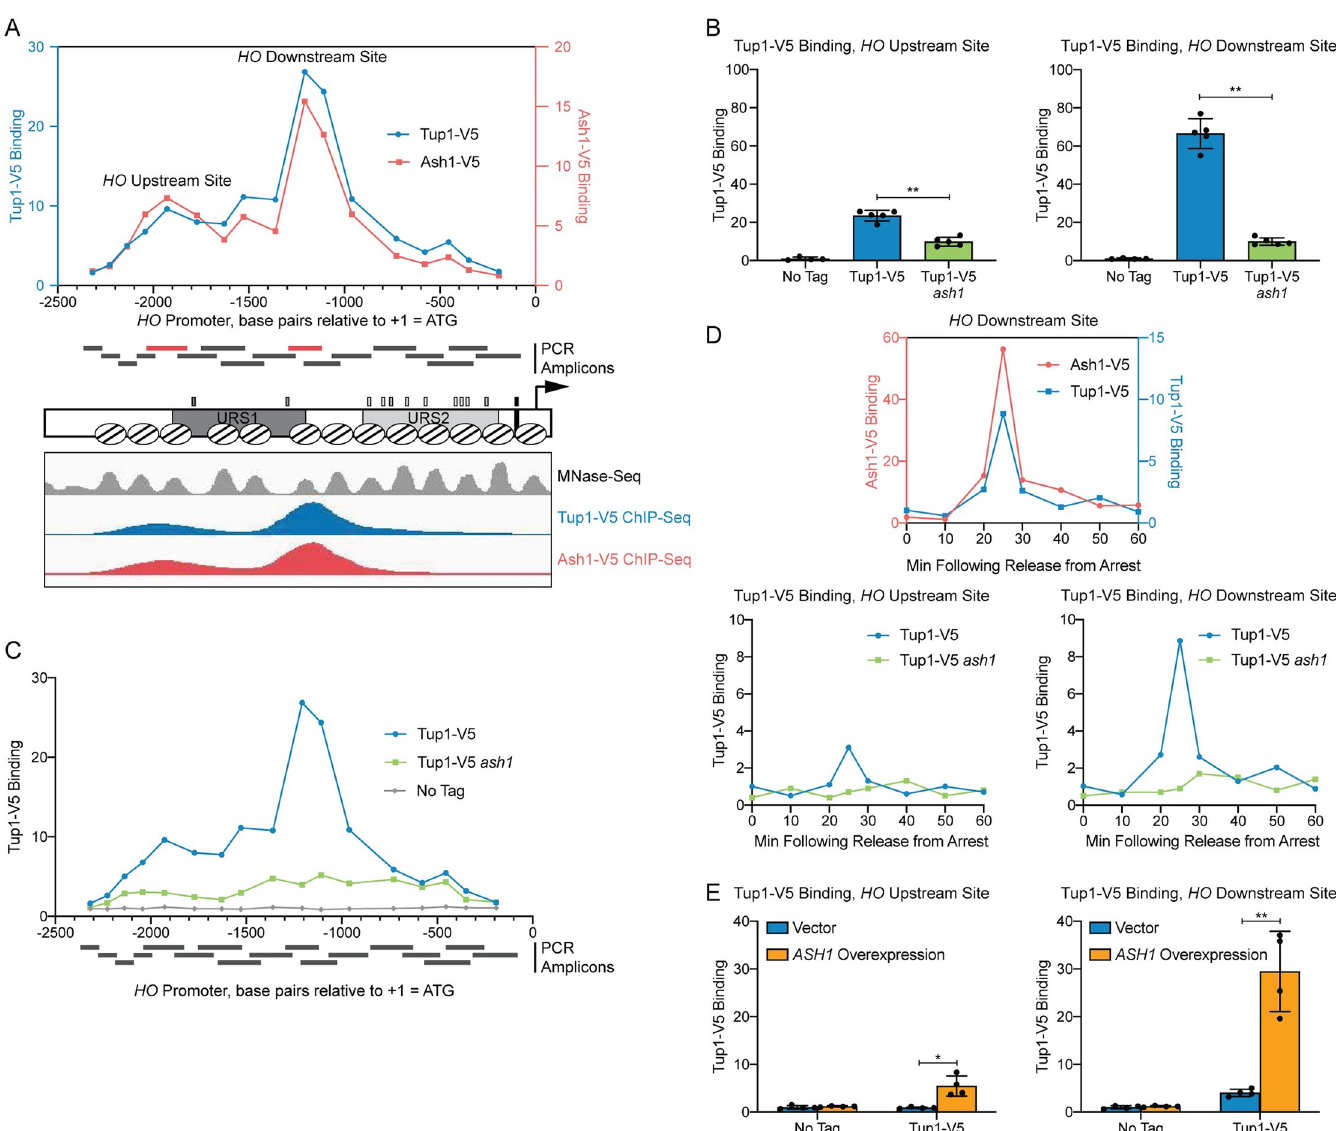
Fig 1. Tup1 associates with the HO promoter via Ash1. (A) There are two peaks of binding at the HO promoter for both Tup1 and Ash1. Binding of Tup1-V5 (blue; left y-axis) and Ash1-V5 (red; right y-axis) to the HO promoter was determined by ChIP, followed by qPCR with primers that span from -2300 to -200 in 75 to 150-bp intervals. Enrichment for each sample at HO was normalized to enrichment at an intergenic region on chromosome V (IGR-V) and to the corresponding input sample. Positions of the PCR amplicons are indicated with gray bars. Points on the graph correspond to the midpoints of these amplicons, with the x-axis indicating position across the HO promoter. Amplicons shown in red display the highest levels of binding of Tup1 and Ash1, labeled as “Upstream Site” (-2033 to -1823) and “Downstream Site” (-1295 to -1121). A schematic of the HO promoter shows the positions of nucleosomes from MNase-Seq [5] as ovals with slanted lines. The positions of Swi5 binding sites (dark gray small rectangles; within URS1), SBF binding sites (light gray small rectangles; within URS2), and the TATA element (black small rectangle) are also indicated. ChIP-Seq for Tup1-V5 (blue) and Ash1-V5 (red) shown in the bottom panel displays peaks of binding at the same Upstream and Downstream Site locations as the traditional ChIP in the top graph. Nucleosome sequences from MNaseq-Seq were trimmed to show only the central 76-nt, allowing their positions to be more easily viewed in the genome browser [5]. (B) Tup1 binding to the HO promoter is reduced in an ash1 mutant at both the Upstream and Downstream sites. Tup1-V5 ChIP analysis at the HO promoter, showing enrichment at the Upstream Site (left; -2033 to -1823) and Downstream Site (right; -1295 to -1121). For each sample, binding at each HO site was normalized to its corresponding input DNA and to a No Tag control. Each dot represents a single data point, and error bars reflect the standard deviation. �� p < 0.01, � p < 0.05. (C) Tup1 binding to the HO promoter is not eliminated in an ash1 mutant. Single samples of Tup1-V5 ChIP from Tup1-V5 (blue), Tup1-V5 ash1 (green) and No Tag control (gray) strains were chosen from B and used for qPCR with primers that span the HO promoter, as in A. Enrichment for each sample at HO was normalized to enrichment at an intergenic region on chromosome V (IGR-V) and to the corresponding input sample. (D) Tup1 and Ash1 bind to the HO promoter at the same time in the cell cycle. Binding of Tup1-V5 and Ash1-V5 was measured by ChIP analysis with cells containing the GALp :: CDC20 allele and synchronized by galactose withdrawal and readdition. The 0 min time point represents the G2/M arrest, before release with galactose addition. Cells were harvested at the indicated time points following release (x-axis), and samples were processed for ChIP analysis. The top graph shows the coincidence of the timing